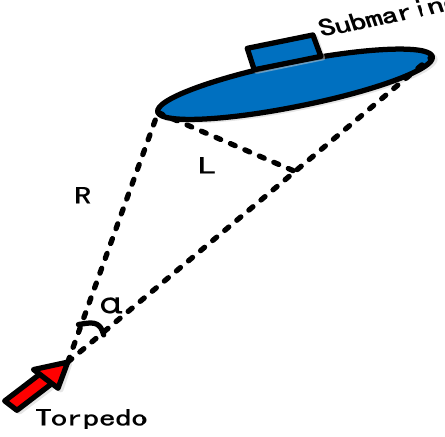
Figure 7. The association between apparent scale and apparent angle.